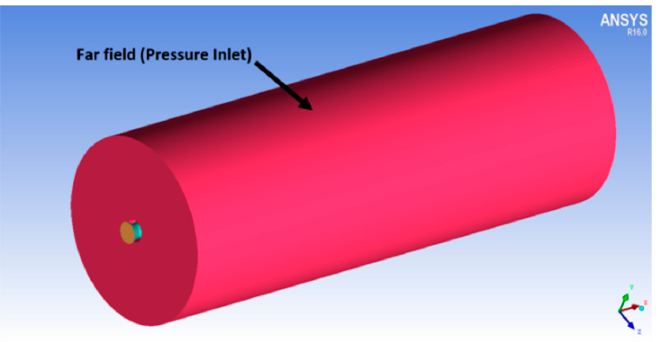
Figure 6. Nozzle wall and rectangular Tabs as wall.